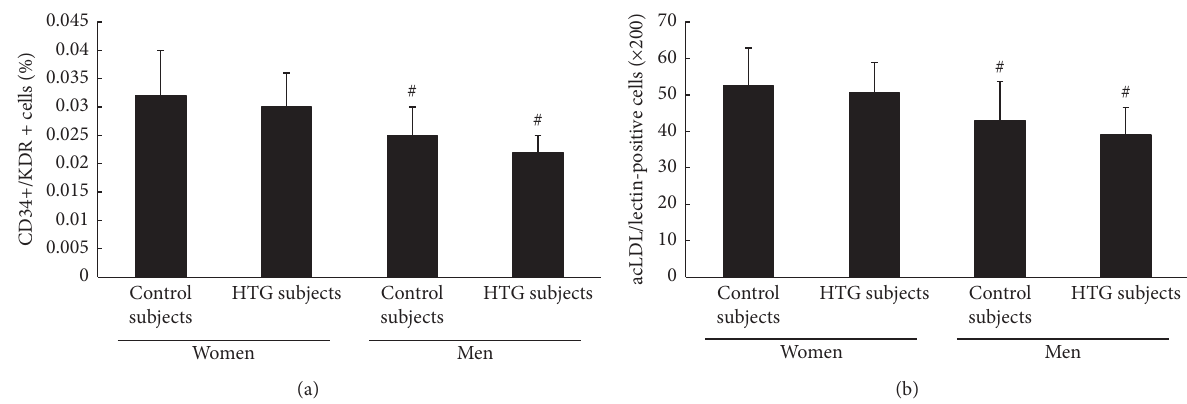
Figure 1: (a) fluorescence-activated cell sorting analysis. (b) Phase-contrast fluorescent microscope. There was no significant difference in the level of circulating EPCs between the normotriglyceridemic and the hypertriglyceridemic women. In both the normotriglyceridemic and hypertriglyceridemic patients, the number of EPCs in women groups was statically higher than that in the men groups. Data were presented as mean ans standard deviation. #vs premenopausal